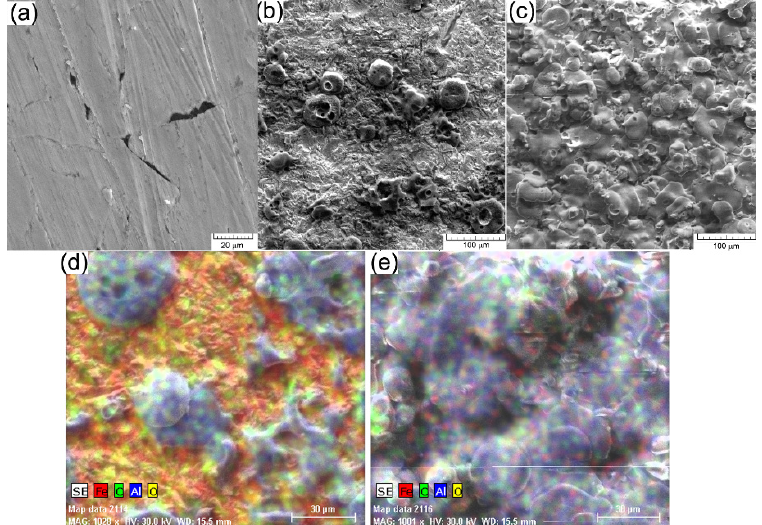
Figure 1. SEM images: ( a ) cast iron EN-GJL-250; ( b ) EN-GJL-250 + 2 layers of ceramic material; ( c ) EN-GJL-250 + 4 layers of ceramic material, in ( d , e ) there are shown distributions of elements inside the deposited ceramic coatings using two and four passes, respectively.